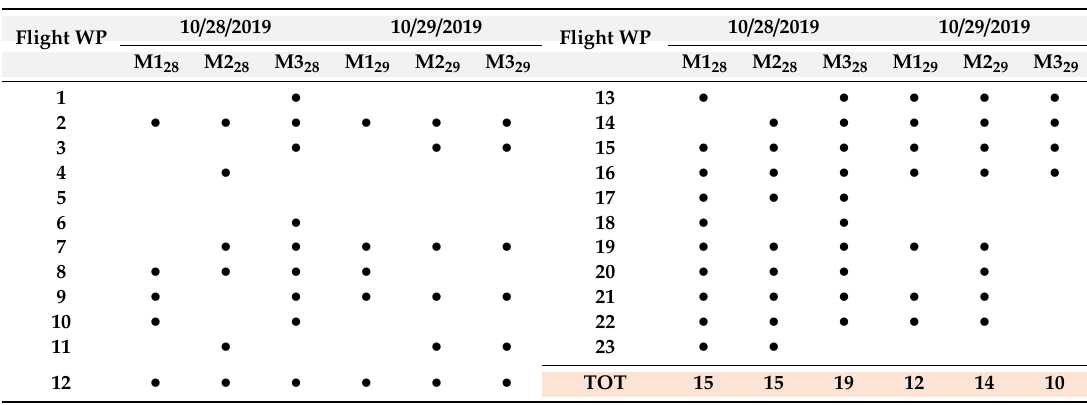
Table 6. For each waypoint and flight over the marshes, a dot indicates that at least one velocity vector was computed. Refer to Figure 5 for a planar view of the waypoints. Refer to Table 1 for the initial time of the